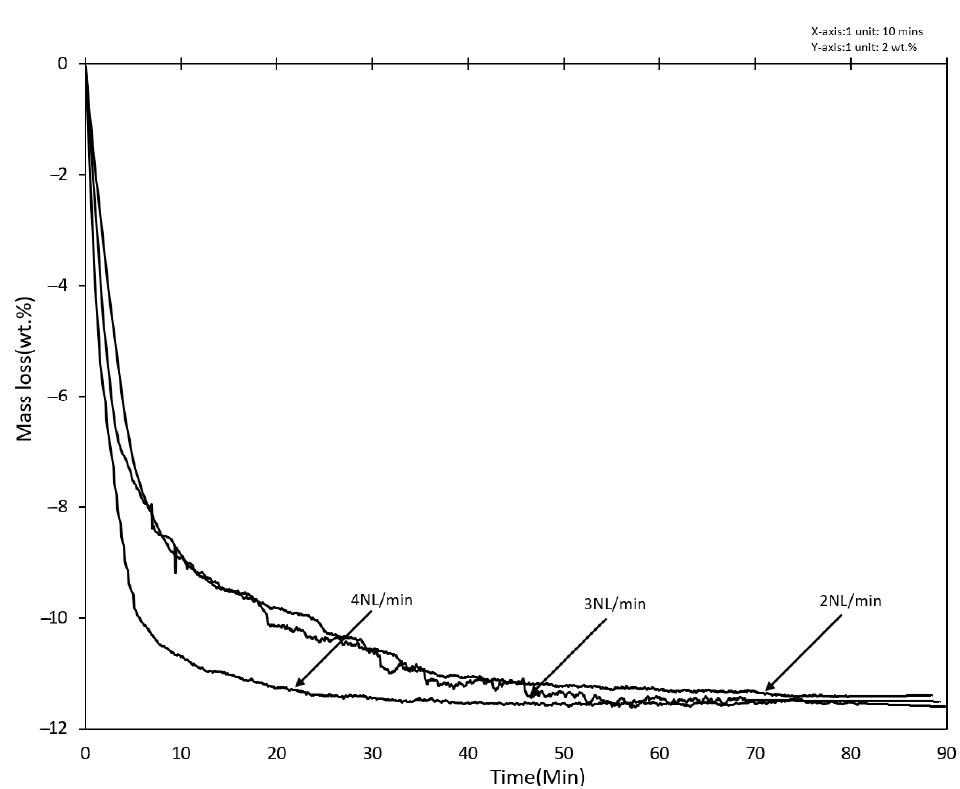
Figure 4. Mass loss plotted against time for different flow rates at constant temperature of 1000 °C.